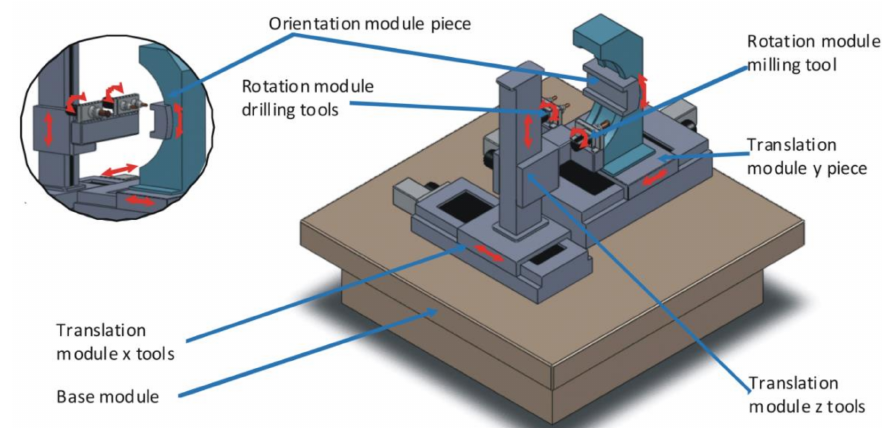
Figure 7. Particle 2 at iteration 2: variant 5.